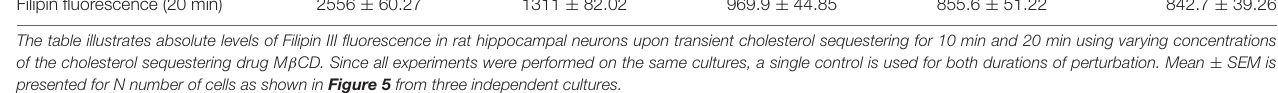
The table illustrates absolute levels of Filipin III fluorescence in rat hippocampal neurons upon transient cholesterol sequestering for 10 min and 20 min using varying concentrations of the cholesterol sequestering drug M β CD. Since all experiments were performed on the same cultures, a single control is used for both durations of perturbation. Mean ± SEM is presented for N number of cells as shown in Figure 5 from three independent